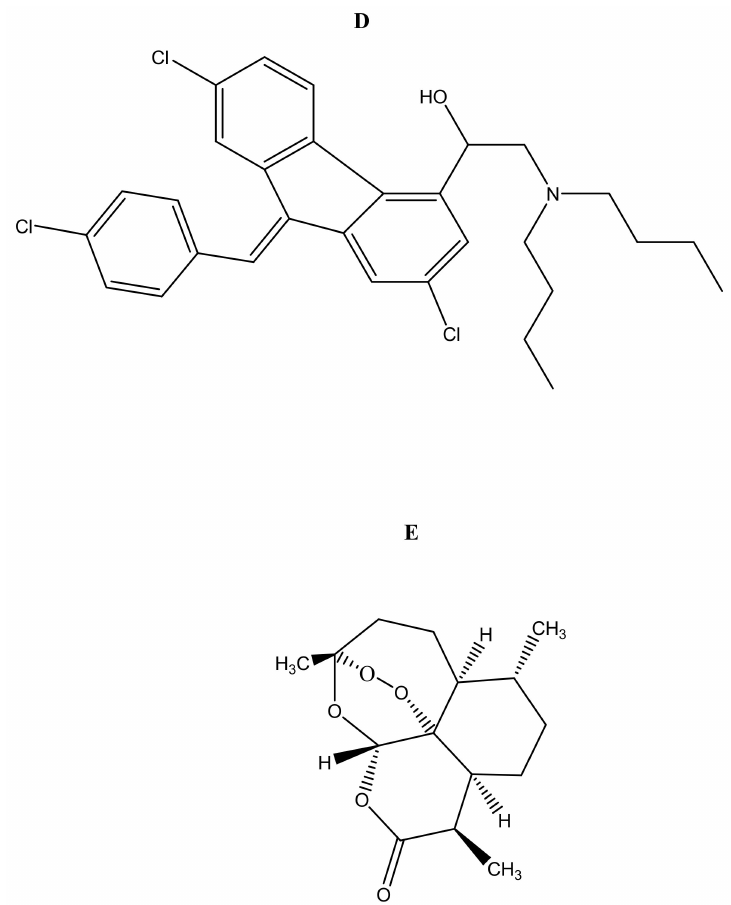
Figure 2. Antimalarials loaded onto polymer based carriers: ( A ) Chloroquine, ( B ) Primaquine, ( C ) Curcumin, ( D ) Lumefantrine, ( E )